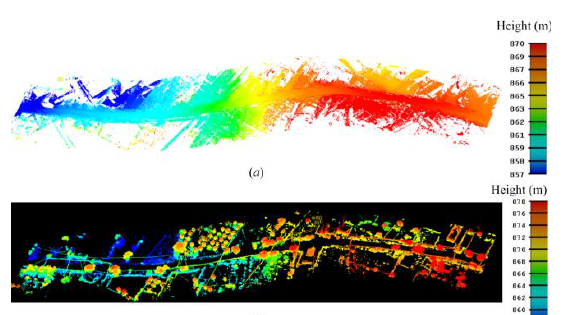
Figure 4. 3D perceptive point cloud view test site